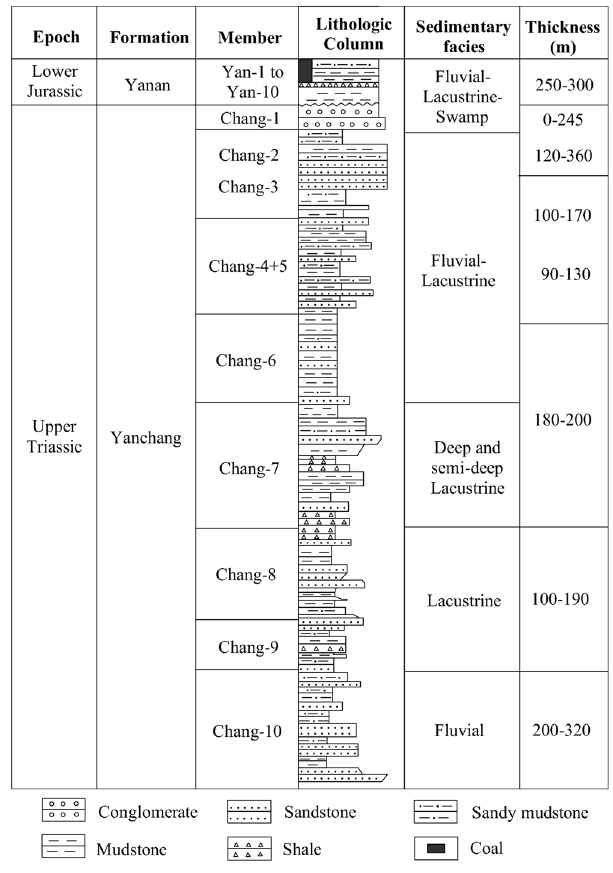
Figure 2. Stratigraphic column of the Yanchang Formation and its sub-members (modified after Guo (2014) 4 ). The source of the map is Marine and Petroleum Geology, Vol. 57, May, 2015. Permission for the map was obtained from an Open Access license with license number 4103990262253. The figure was created using the Chinese version of CorelDraw Graphic Suite X8. (http://www.coreldraw.com/cn) 57: 509–520.